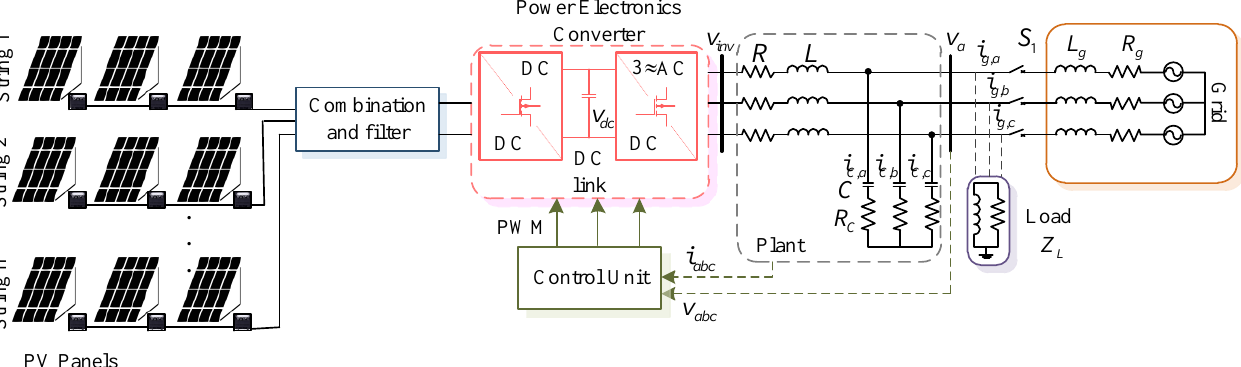
Figure 1. Configuration of three-phase grid-connected distributed generation unit with RL load.